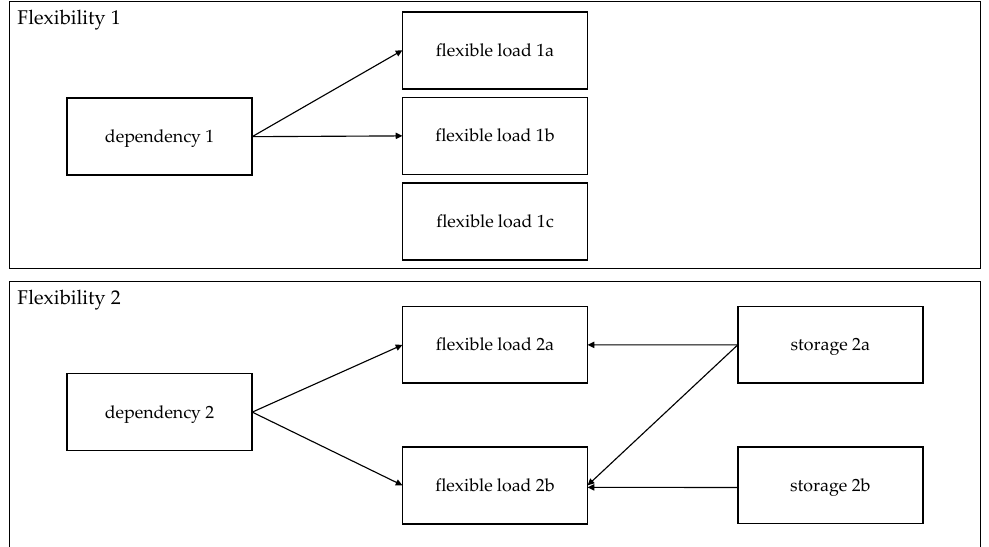
Figure 1. The generic data model enables a uniform and modular description of industrial